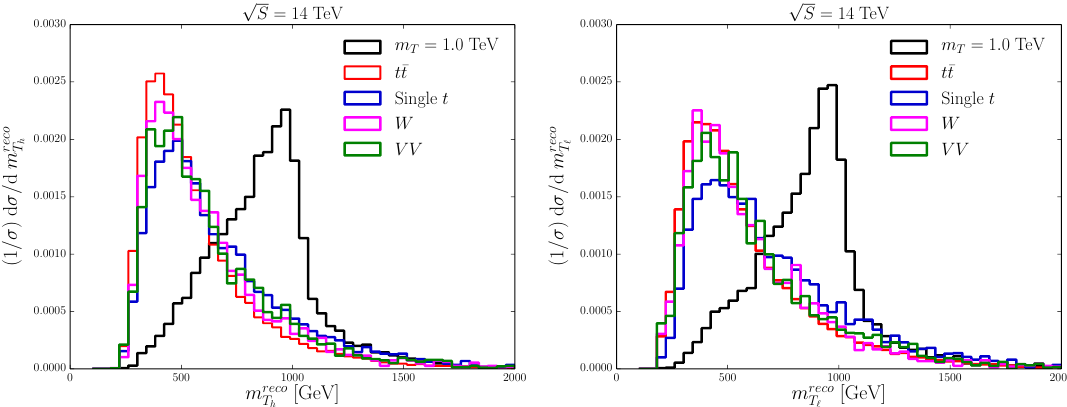
(left) and m reco T h T ‘